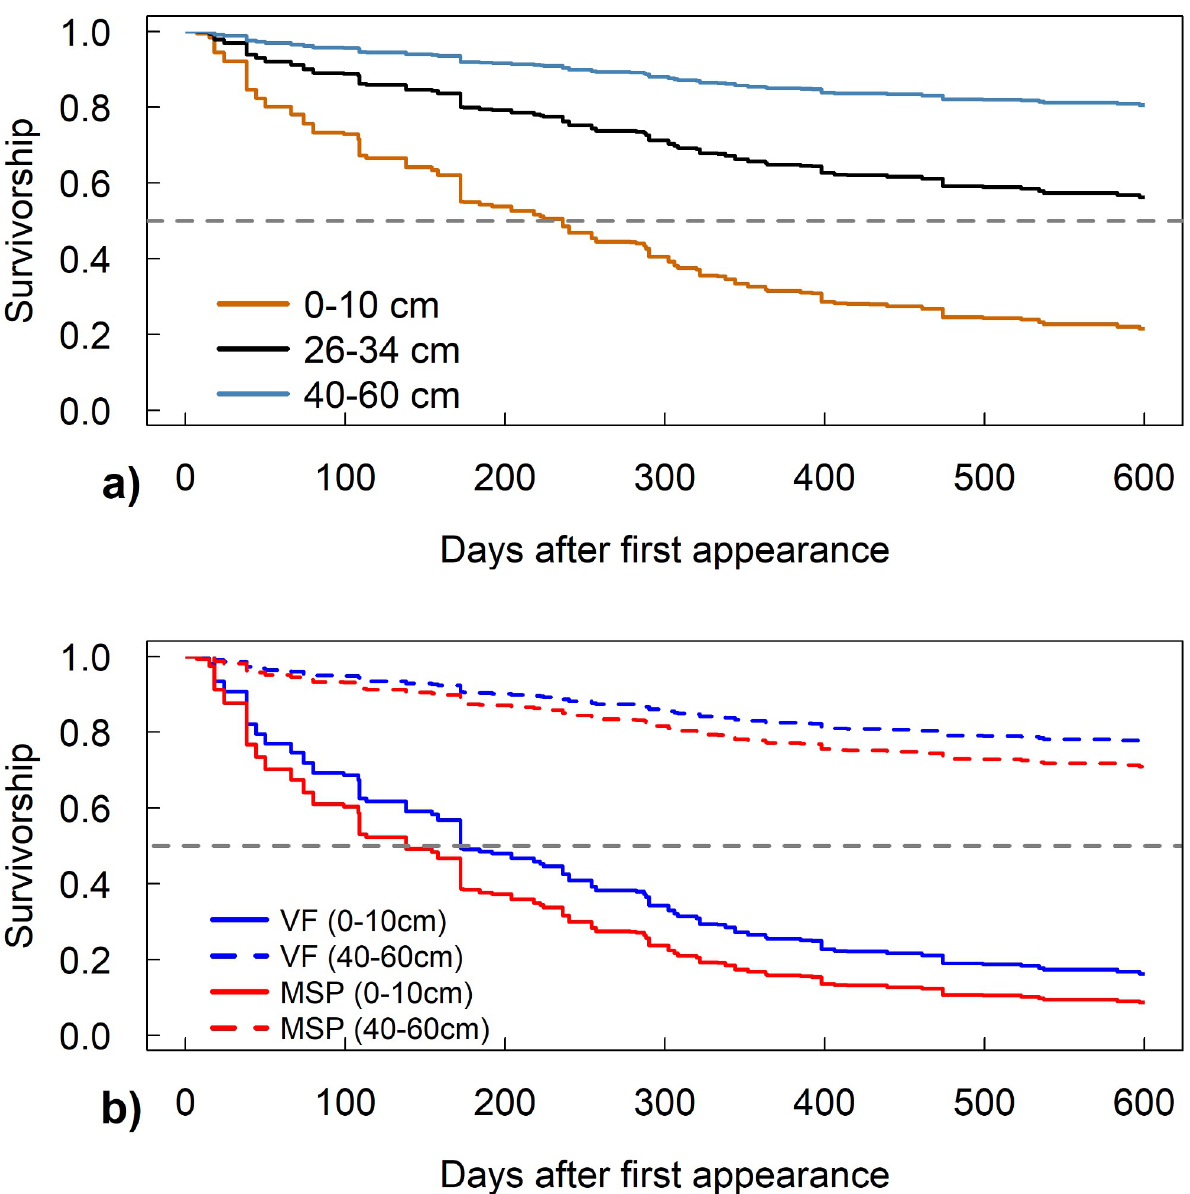
Fig 3. Survivorship of roots at different depths and topographic locations. (a) Survivorship curves of first-order roots at different soil depths born in the fall of 2017 at swale locations. (b) Survivorship curves of first-order roots at different soil depths at valley floor (VF) and midslope planar (MSP)